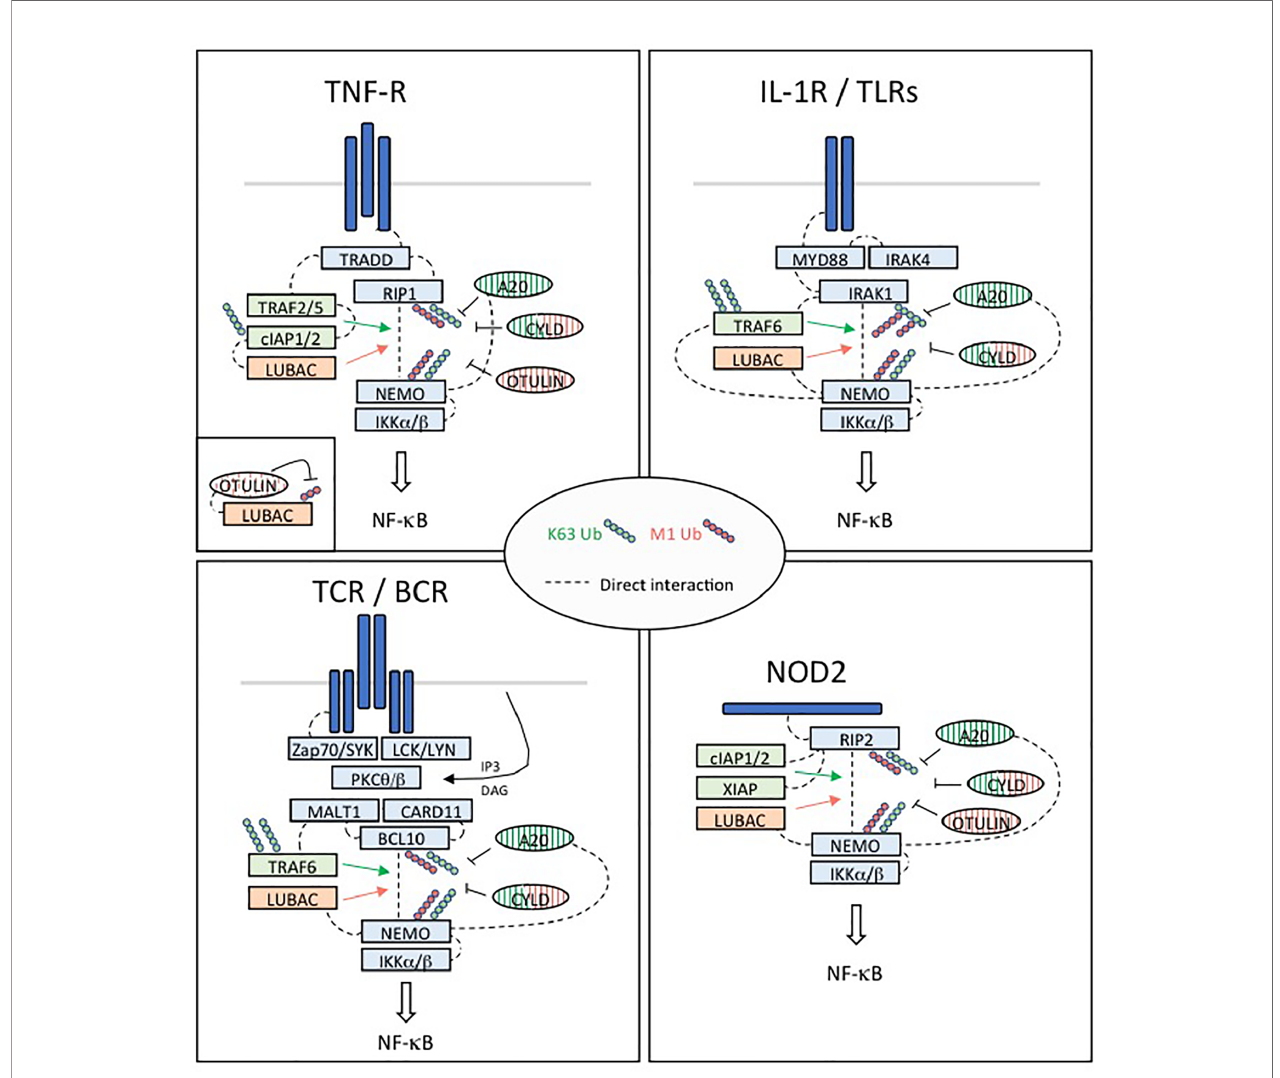
FIGURE 4 | Regulation of NF- k B activation in four different pathways implicated in immune tolerance. TNFR: Upon binding of TNF a , the TNFR1 receptor trimerizes resulting in the recruitment of TRADD to the death domain (DD) of the receptors cytoplasmic tail. RIP1 is recruited through TRADD and TNFR1 through homotypic DD interactions. High af fi nity binding of TRAF2 trimers to TRADD is augmented by TRAF2/RIP1 interactions. TRAF2 trimers recruit cIAP1/2, which in turn recruit the LUBAC complex (HOIP, HOIL-1 and SHARPIN), while RIP1 mediates recruitment of TAK1 and the IKK complex through NEMO. This signaling complex (complex I) signals to NF- k B by recruiting in proximity TAK1 and the IKK complex supporting phosphorylation and activation of IKK. The ubiquitin ligase cIAP1/2 and LUBAC may facilitate TAK1 and IKK activation through production of linear and/or K63 linked ubiquitination. Then, activated IKK phosphorylates I k B a leading its ubiquitination and degradation and nuclear translocation of p65:p50 NF- k B complexes. DNA bound canonical NF- k B induces transcription of immune response genes as well as genes that protect the cell from TNF induced cell death. IL1R/TLRs: Despite differences in their extracellular domains, the IL-1 receptor (IL-1R) and TLRs contain a common cytoplasmic motif termed the Toll/IL-1R (TIR) homology domain, which is required for activation of NF- k B signaling pathways. IL-1R- and TLR-mediated NF- k B activation is initiated by the recruitment of MyD88 to the TIR. MyD88 is a scaffold protein that recruits the death domain-containing protein IRAK-1, IRAK-2, IRAK-4, and the ubiquitin protein ligase (E3) TRAF6. IRAK-4 and TRAF6 are essential signaling components of IL-1R- and TLR-mediated MAPK and NF- k B activation. IRAK-1 also plays an important role in IL-1R/TLR signaling in order to induce IKK activation and subsequently I k B activation and NF- k B nuclear translocation. TCR/BCR: In response to TCR or BCR triggering, phosphorylation of CARD11 (CARMA1) by PKC- q or PKC- b on different Serine residues of its linker domain modi fi es its conformation allowing its association with a constitutively associated dimer formed by BCL10 and MALT1, leading to the assembly of the CBM complex. The formation of this complex constitutes one of the important steps towards NF- k B stimulation following TCR/BCR engagement. In turn, this complex activates the I k B kinase (IKK) responsible for the phosphorylation of the inhibitory factors I k B a and their subsequent degradation, allowing activation and nuclear translocation of NF- k B followed by transcription of its target genes. In addition to its scaffold function during NF- k B signaling, the paracaspase MALT1 exerts a proteolytic activity to ensure the regulation of NF- k B activation. NOD2: NOD2 immune function drive a higher incidence of autoimmune diseases such as Crohn ’ s disease. NOD2-mediated signaling relies on RIP2. RIP2 recruits a number of signaling regulators to the NOD2-associated protein complex, including several ubiquitin E3 ligases such as XIAP, c-IAP1/2, Pellino3, and LUBAC, which promote diverse ubiquitination of RIP2. XIAP is a critical ubiquitin ligase in the NOD2-RIP2 in fl ammatory pathway and promotes NEMO/IKK- mediated NF- k B